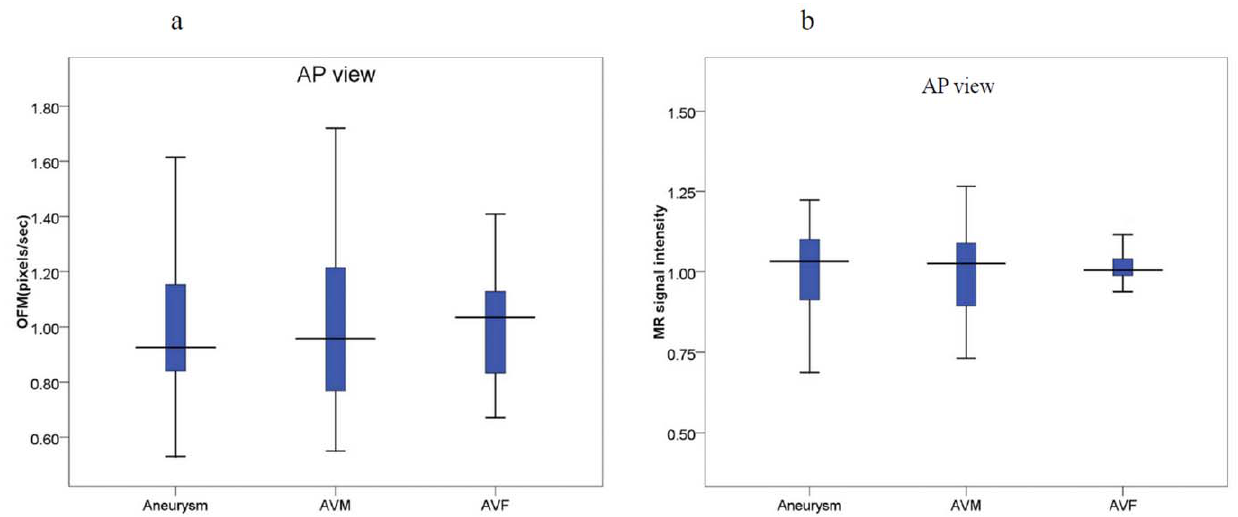
Figure 6. The box plots for an aneurysm, AVM, and AVF compared to (a) the blood flow distribution parameters in the AP view and (b) MRA